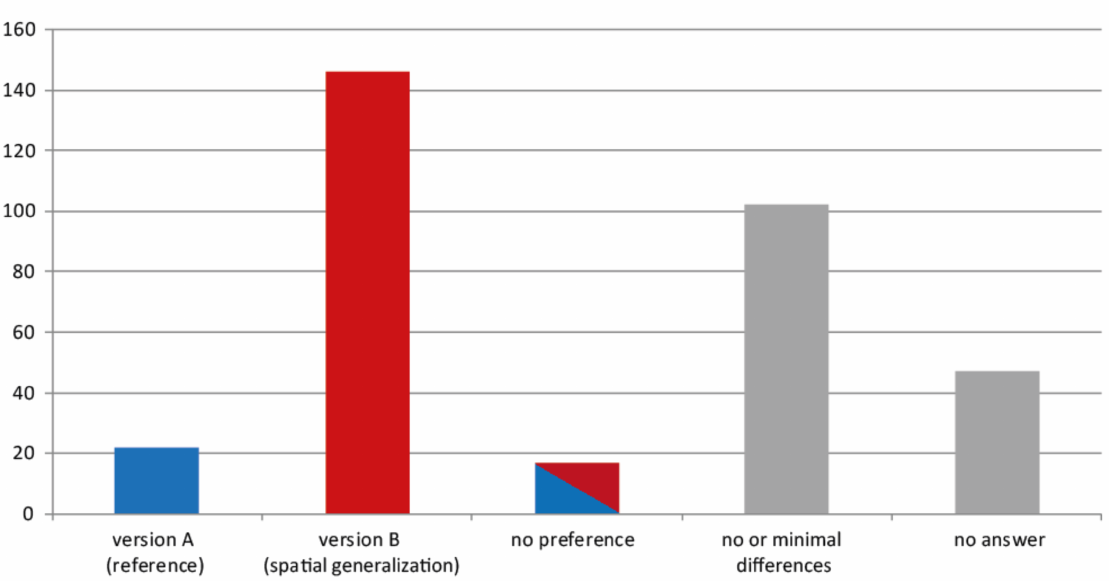
Figure 16. Answers for “Which version is easier to understand?” Absolute counts, n =